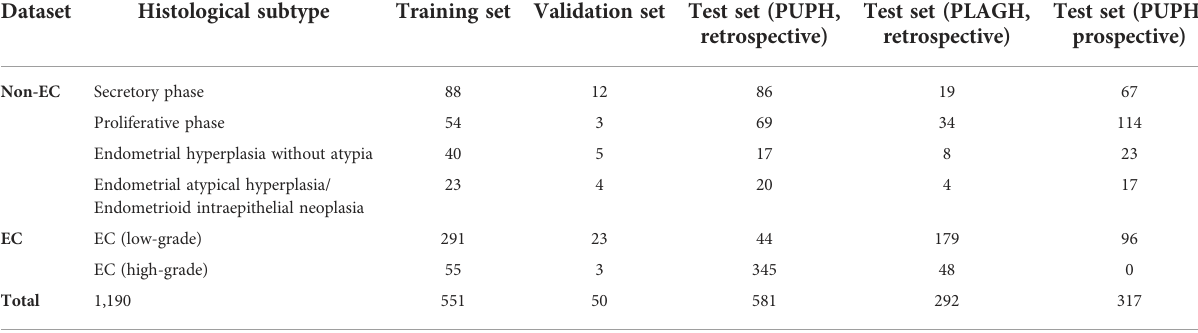
TABLE 1 Characteristics of the whole-slide images of endometrial specimens.